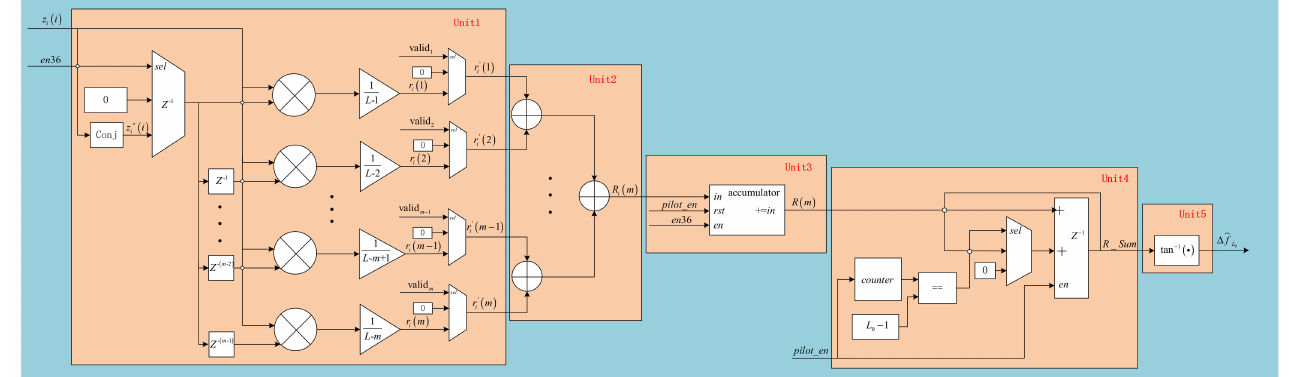
Figure 6. Block diagram of carrier frequency offset estimation regarding RLR